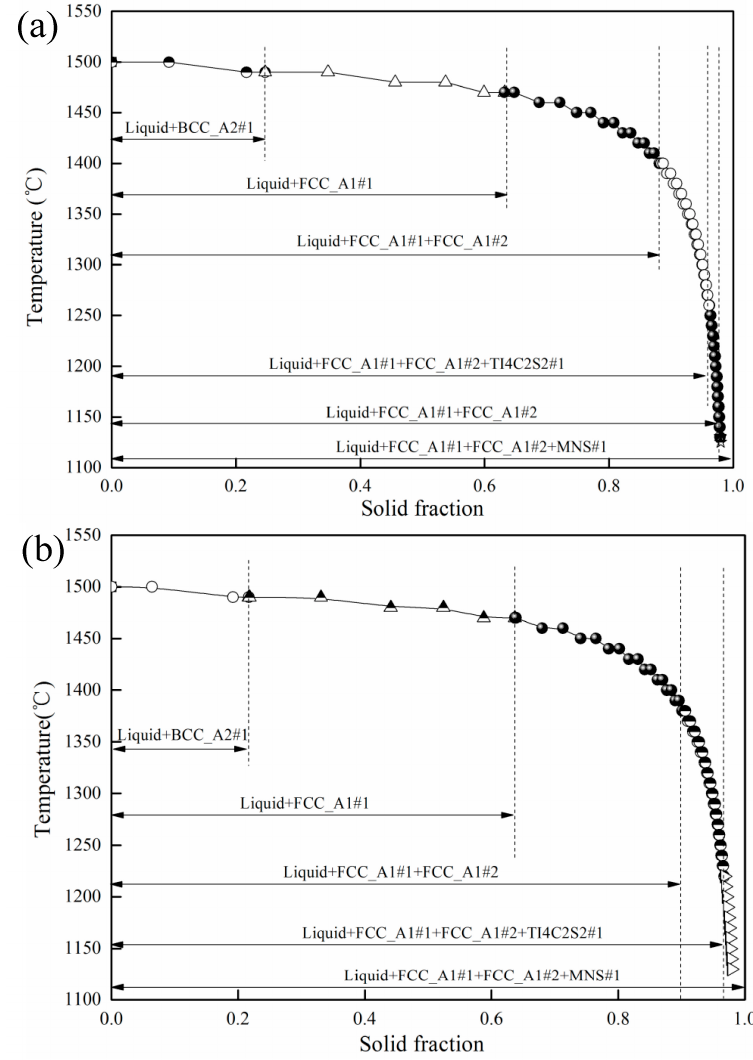
Figure 14. Variation of solid fraction with temperature for steel 1 ( a ) and steel 2 ( b ) during solidification.